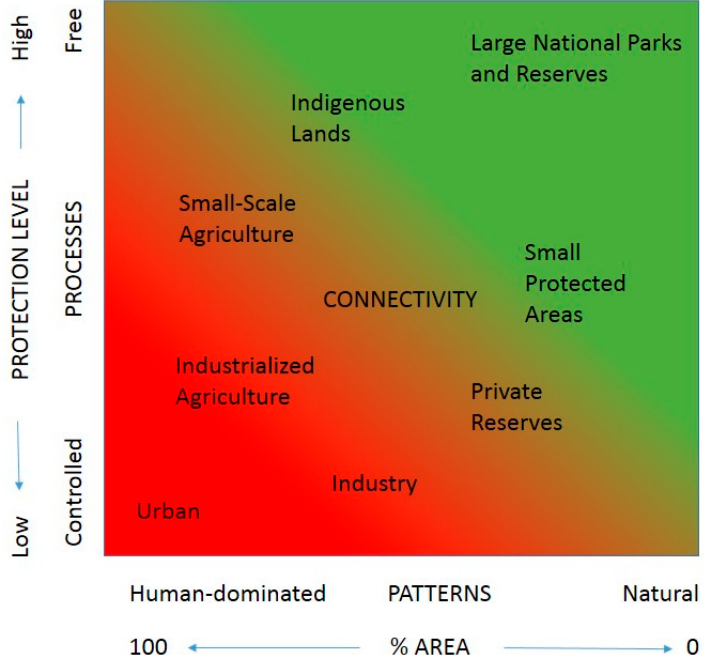
Figure 2. A gradient view of protected areas adapted from a human modification gradient (Theobald 2004) [35]. There are protected areas in virtually every human landscape context. Connectivity is noted in capital letters in the center in the portion of the gradient.